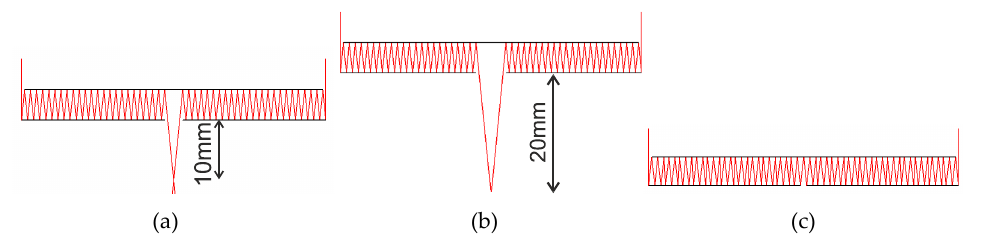
Figure 5. An imaging system with D = 50 mm and f = 250 mm. ( a ) The mirrors are 5 mm apart and the working segment is 10 mm; ( b ) The mirrors are 5 mm apart and the working segment is 20 mm; and ( c ) The mirrors are 4.5 mm apart and focusing is on the secondary mirror plane.